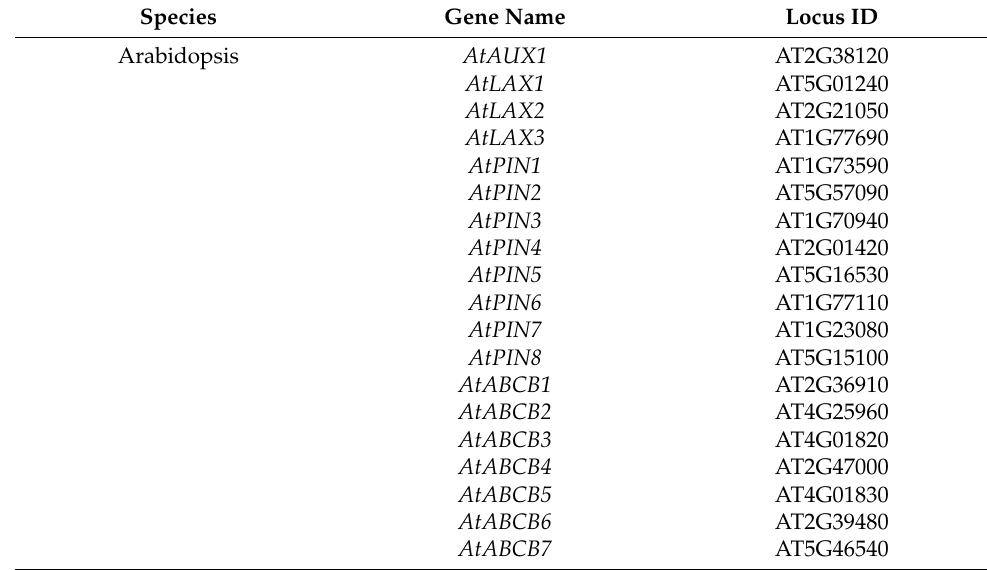
Table A5. Protein sequences used in the phylogenetic relationship